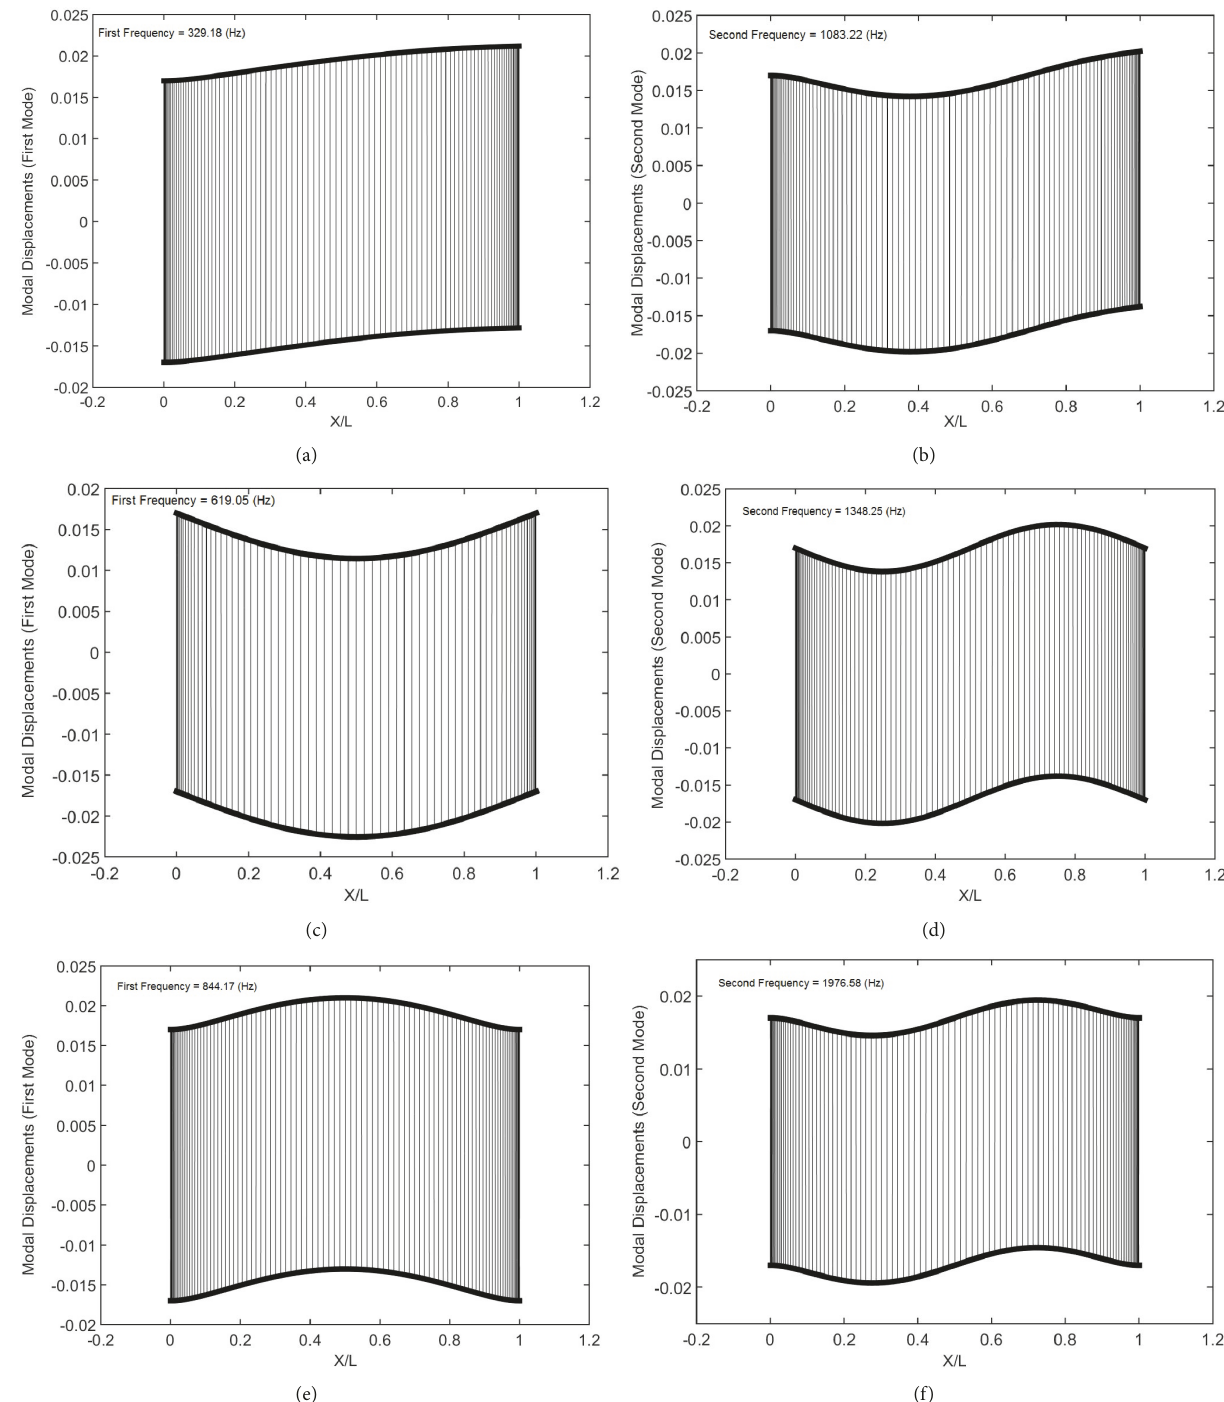
Figure 2: The first two mode shapes of sandwich beam with cantilever ((a) and (b)), simply-simply ((c) and (d)), and clamped-clamped ((e) and (f)) supported